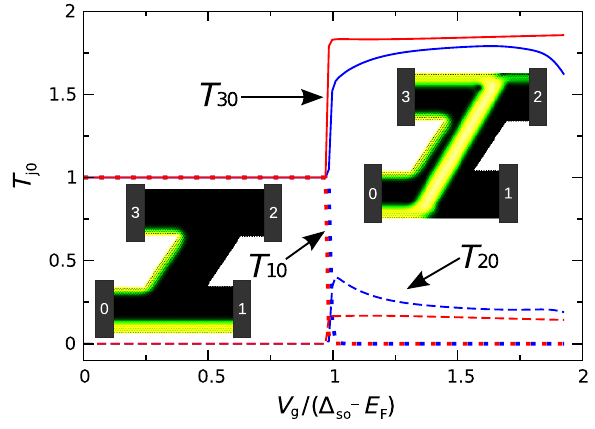
FIG. 5. Heterostructure in a four-terminal Z-shape sample as depicted in Fig. 1(c). Transmission probabilities from lead 0, where the current is injected, to outgoing leads 1 (dotted lines), 2 (dashed lines), and 3 (solid lines) as a function of the top gate < ð (cid:2) (cid:2) E Þ , such that left and right . When V voltage V g g so F regions are in the QSH phase, current is perfectly transmitted by the QSH edge states, as shown in the current-density plot in > ð (cid:2) (cid:2) E Þ ] that the is high enough [ V the left inset. When V g g so F right part of the sample enters the QH phase, a QSH-QH junction is created, characterized by a chiral state propagating along the interface. This is illustrated in the current-density plot shown in the right inset. Once it has reached the opposite edge, this chiral state is partially transmitted in lead 2 and partially transmitted in lead 3, with proportions shown in the main plot. The light red curves correspond to an abrupt voltage change across the junc- tion region while the dark blue curves correspond to a smooth = (cid:2) ¼ 0 : 58 (in the left half of the transition. Parameters are E ffiffiffi p F so ¼ 0 : 02 , l B ’ 8 , and widths W ¼ W ¼ 40 3 for sample), (cid:1) so 0 c the leads and central